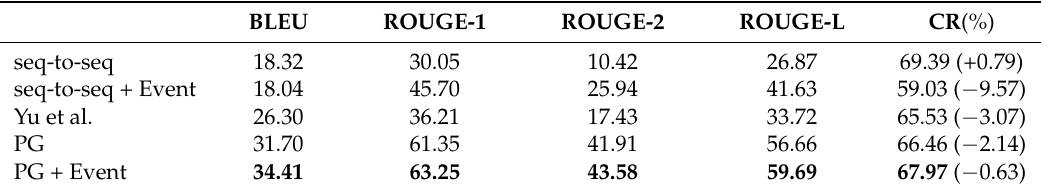
Table 3. Experimental results on MSR dataset.